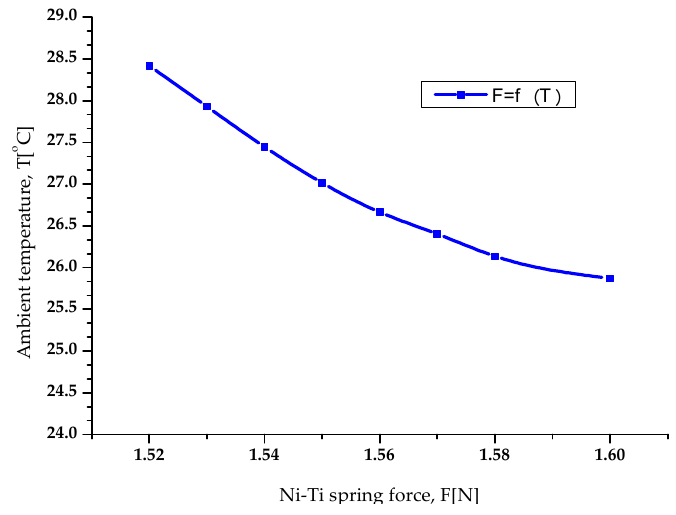
Figure 5. The influence of ambient temperature on the force generated by the Ni-Ti.